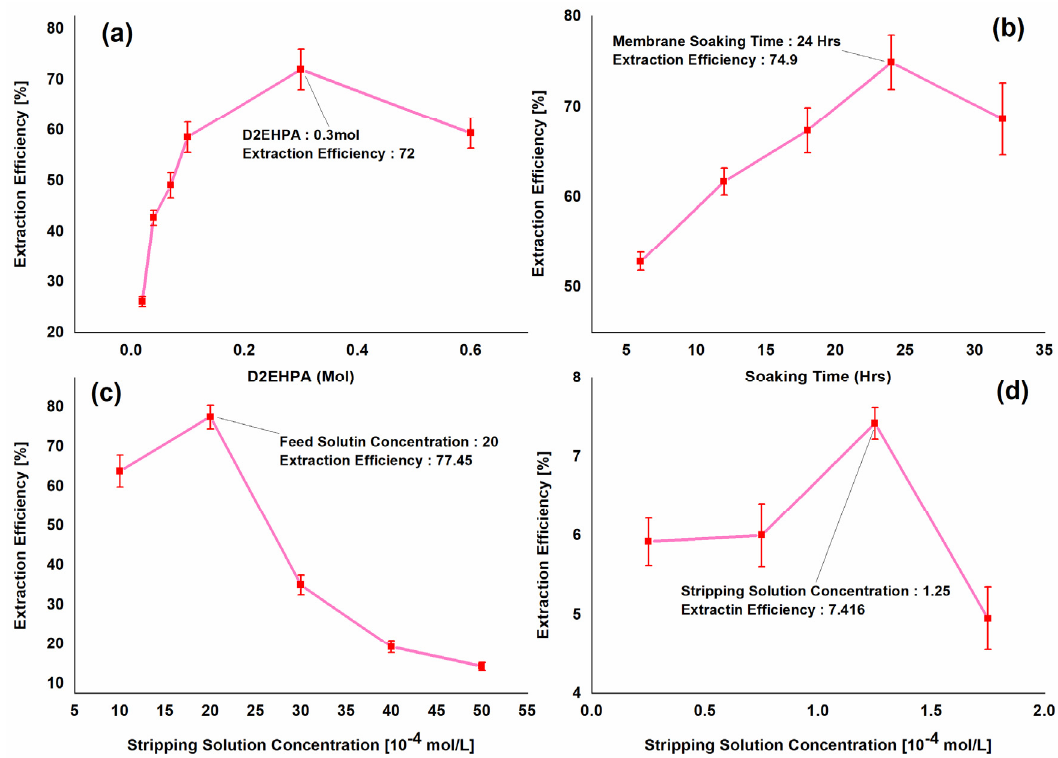
Figure 9. Extraction efficiency at various concentrations of D2EHPA ( a ), membrane soaking time ( b ), initial concentration of feed phase ( c ), and initial concentration of strip phase ( d ) for Cr (III)